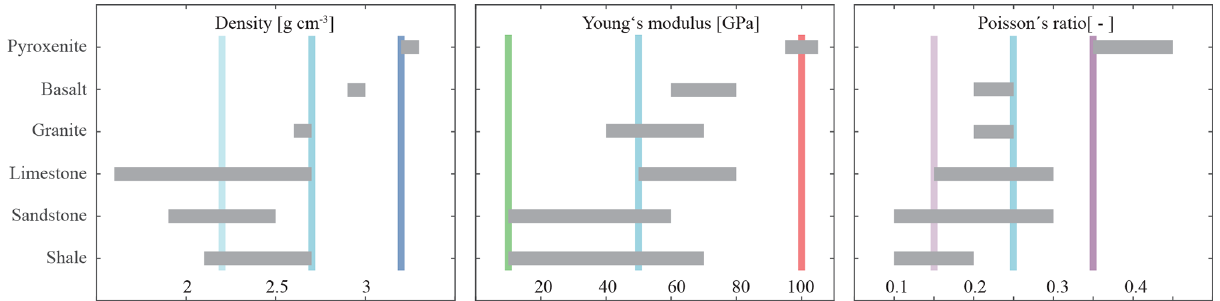
Figure 3. Selection of common elastic rock properties (Young’s modulus and Poisson’s ratio) and density (Turcotte et al., 2014). Coloured vertical bars indicate applied material properties; see Table 2.